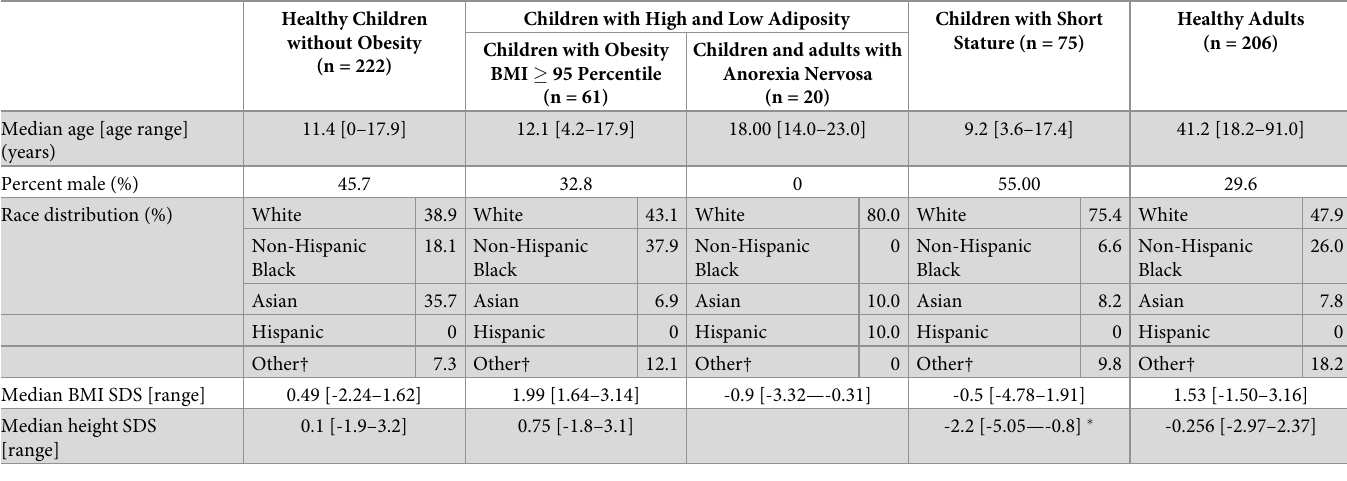
Table 1. Demographic and anthropometric data of